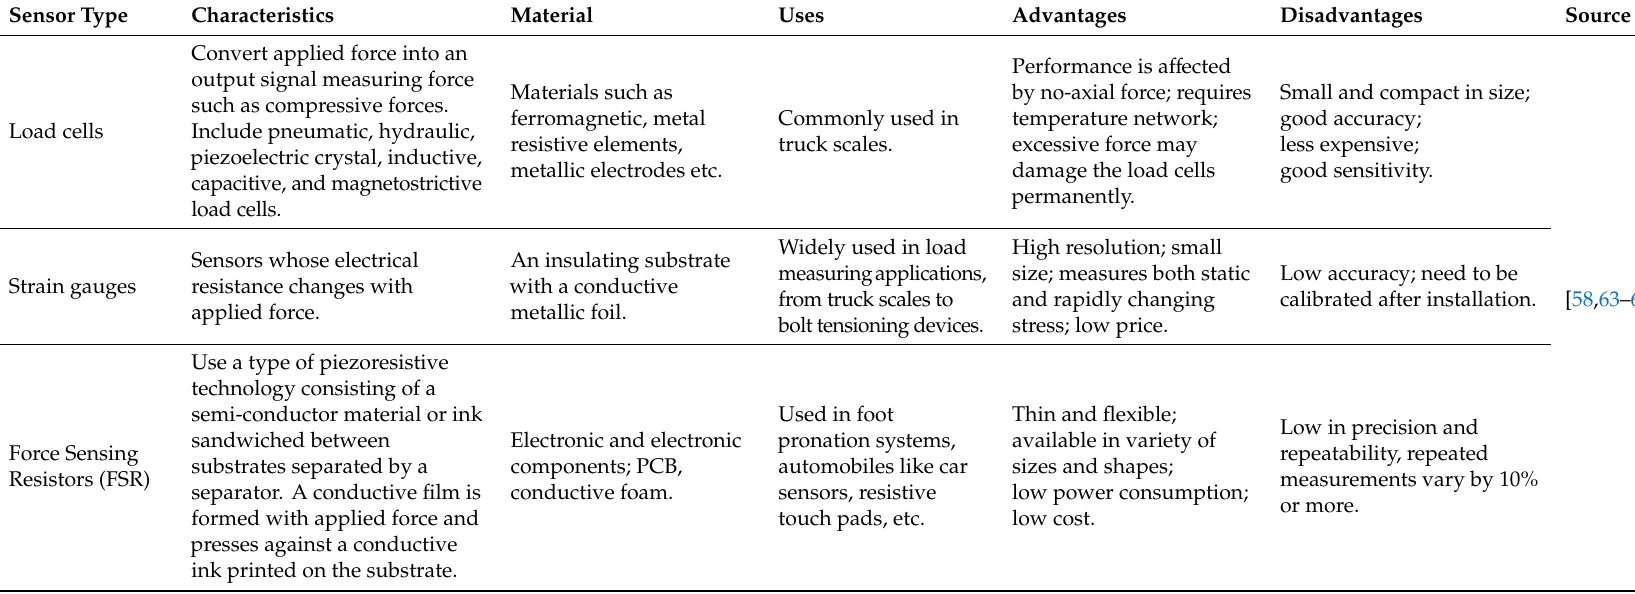
Table 5. Key features of force